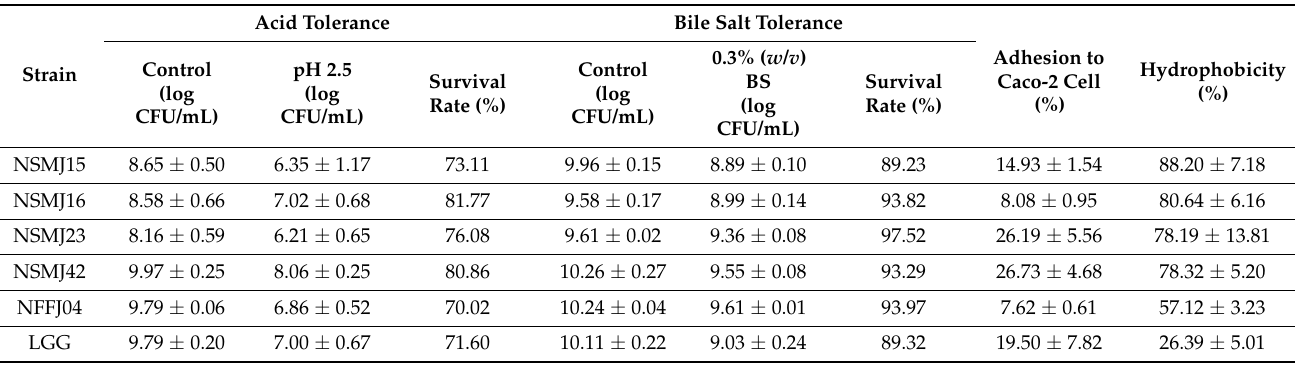
Table 1. Acid and bile tolerance, adhesion (%) to Caco-2 cells, and hydrophobicity (%) of five selected lactic acid bacteria (LAB) strains.